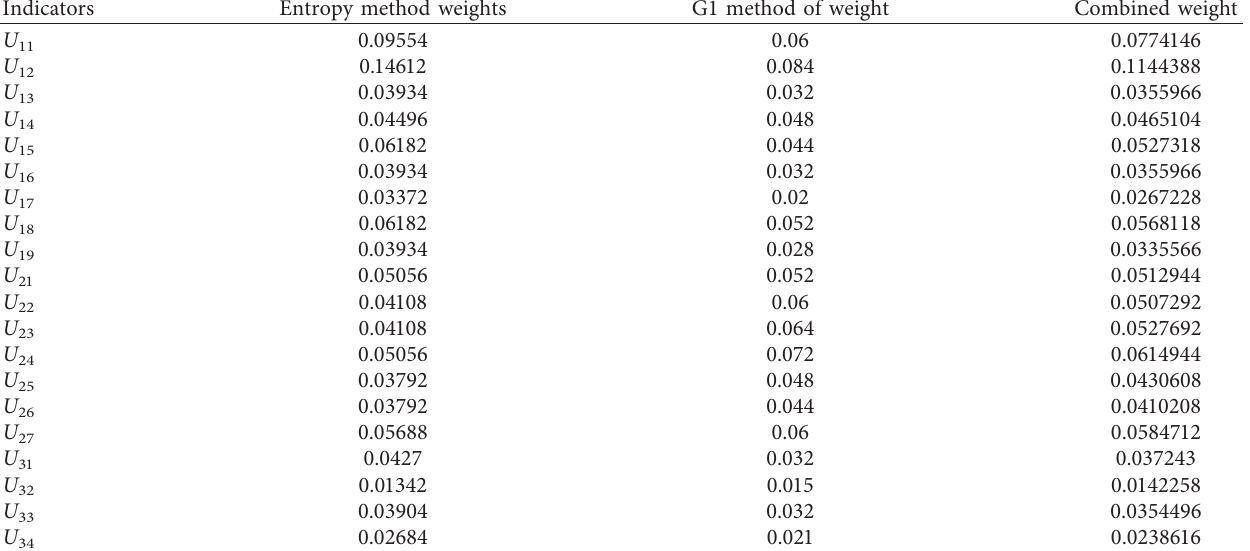
Table 7: Combined weight.